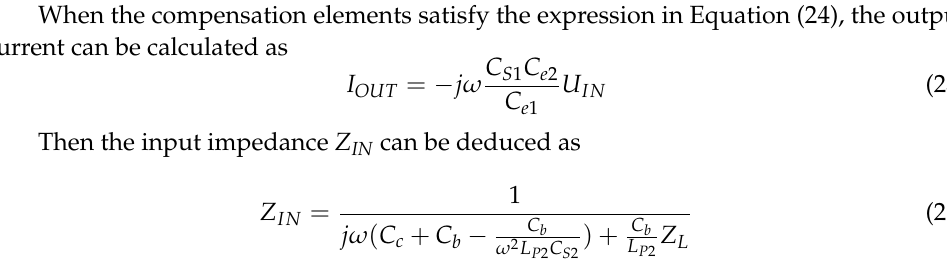
Figure 8. Double-sided CL compensation topology with π -type coupler model.